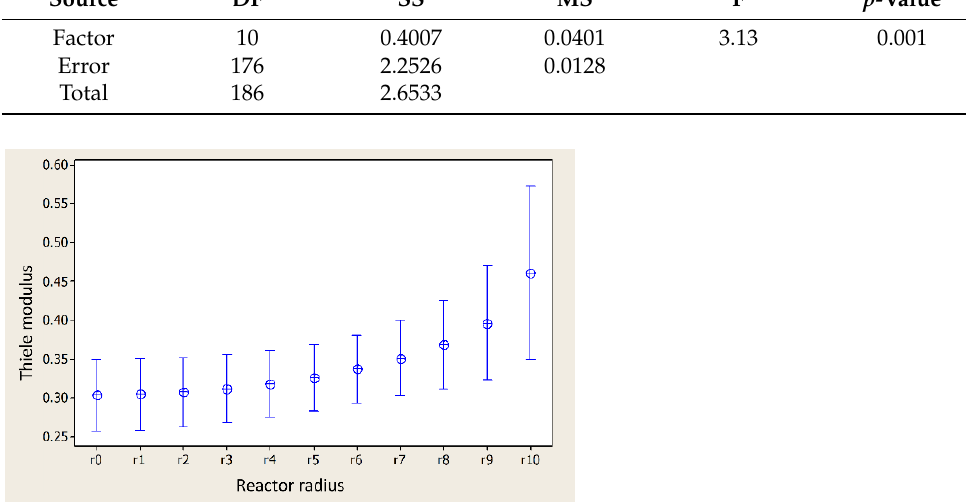
Figure 7. Thiele modulus vs. reactor radius (obtained from Table A4). Interval plot 95% CI for the mean. Table 4. Analysis of variance of the Thiele modulus versus the reactor radius.